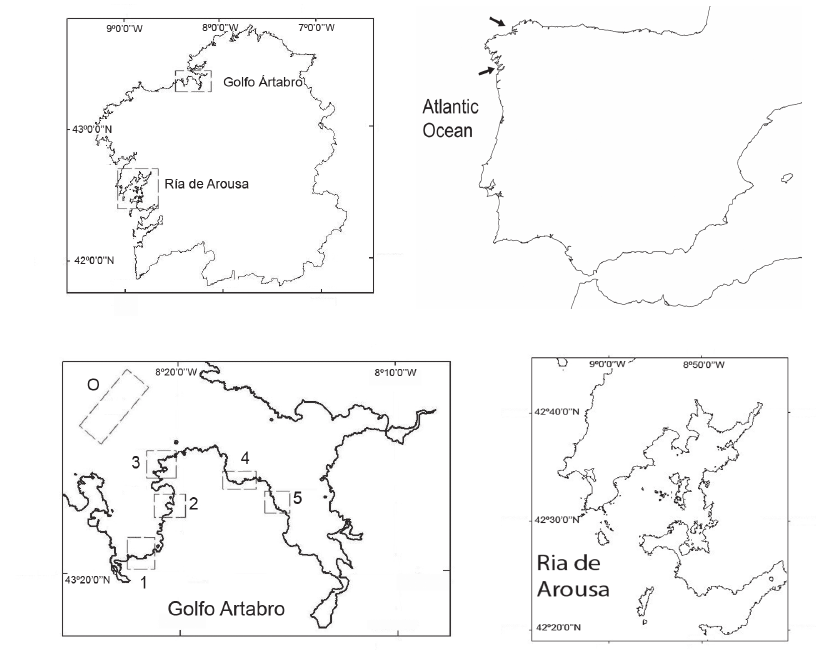
Fig . 1. – location of sampling areas in the Golfo artabro and ria de arousa; 1 to 5, coastal embayments, o: oceanic station; 1: bastiagueiro; 2: Canide; 3: Canabal; 4: lorbé; 5: Carnoedo. Maja brachydactyla were obtained from the ria de arousa and station 1 and 3 in Golfo artabro. Food web samples were obtained at all locations from the Golfo